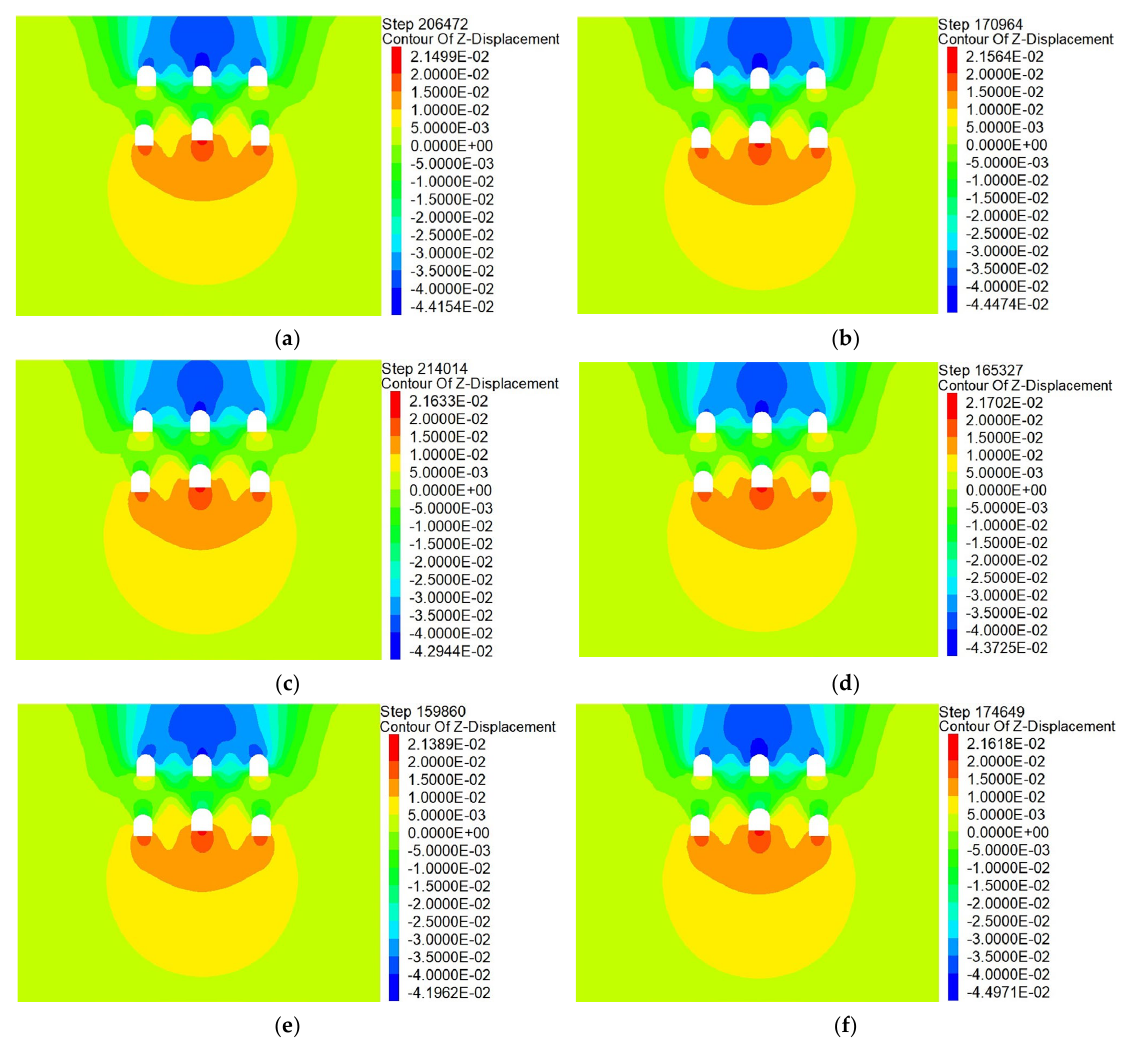
Figure 17. Vertical displacement clouds of different construction schemes: ( a ) plan 1; ( b ) plan 2; ( c ) plan 3; ( d ) plan 4; ( e ) plan 5; ( f ) plan 6.